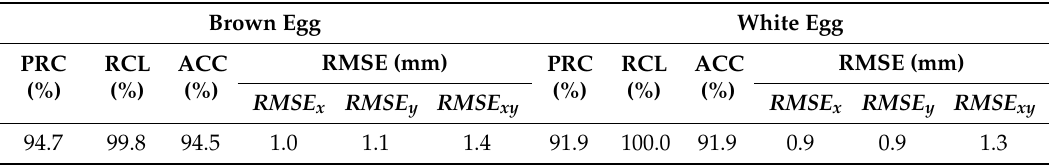
Table 7. Performance of the faster region-based convolutional neural network (faster R-CNN) floor-egg on floor egg detection under random settings using 150 images for each type of eggs. Brown Egg White